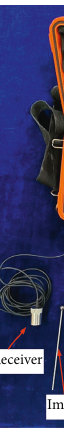
Figure 6: Instruments for IE